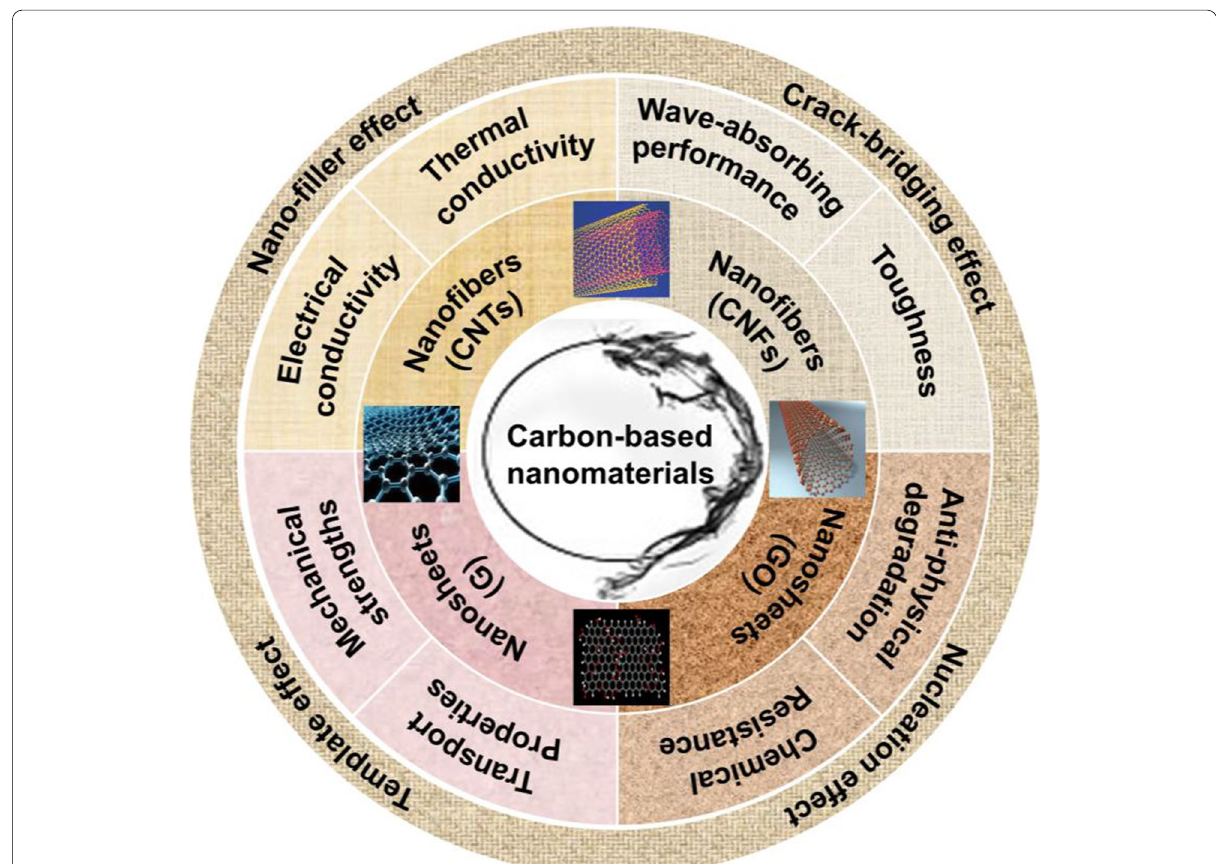
Fig. 1 The roles of the typical 1D nanofibers (CNTs and CNFs) and 2D nanosheets (graphene and GO) in cement composites [19, 22, 28, 34, 39, 45, 47–49]. G represents